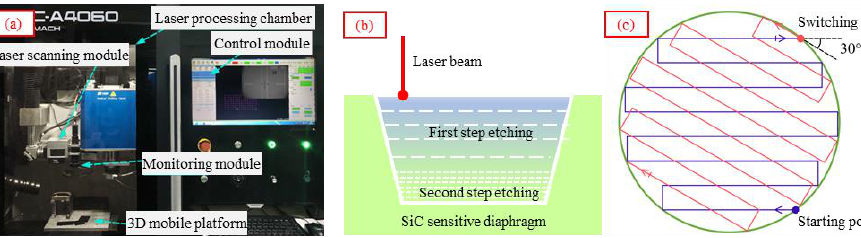
Figure 7. ( a ) A three-axis femtosecond laser micromachining system, ( b ) schematic diagram of the two-step laser etching of the SiC ( c ) and the schematic diagram of the laser scanning path. Table 1. Process parameters of femtosecond laser etching. Finally, the laser etched surface was further etched using ICP etching to reduce the roughness; the etching depth was 20–30 µ m and the average etching rate was 0.8 µ m/min. The total etching depth of the SiC cavity was 270–300 µ m, and a circular, flat diaphragm with a thickness of 50–80 µ m was obtained as shown in Figure 8, and the surface roughness of the diaphragm is 141